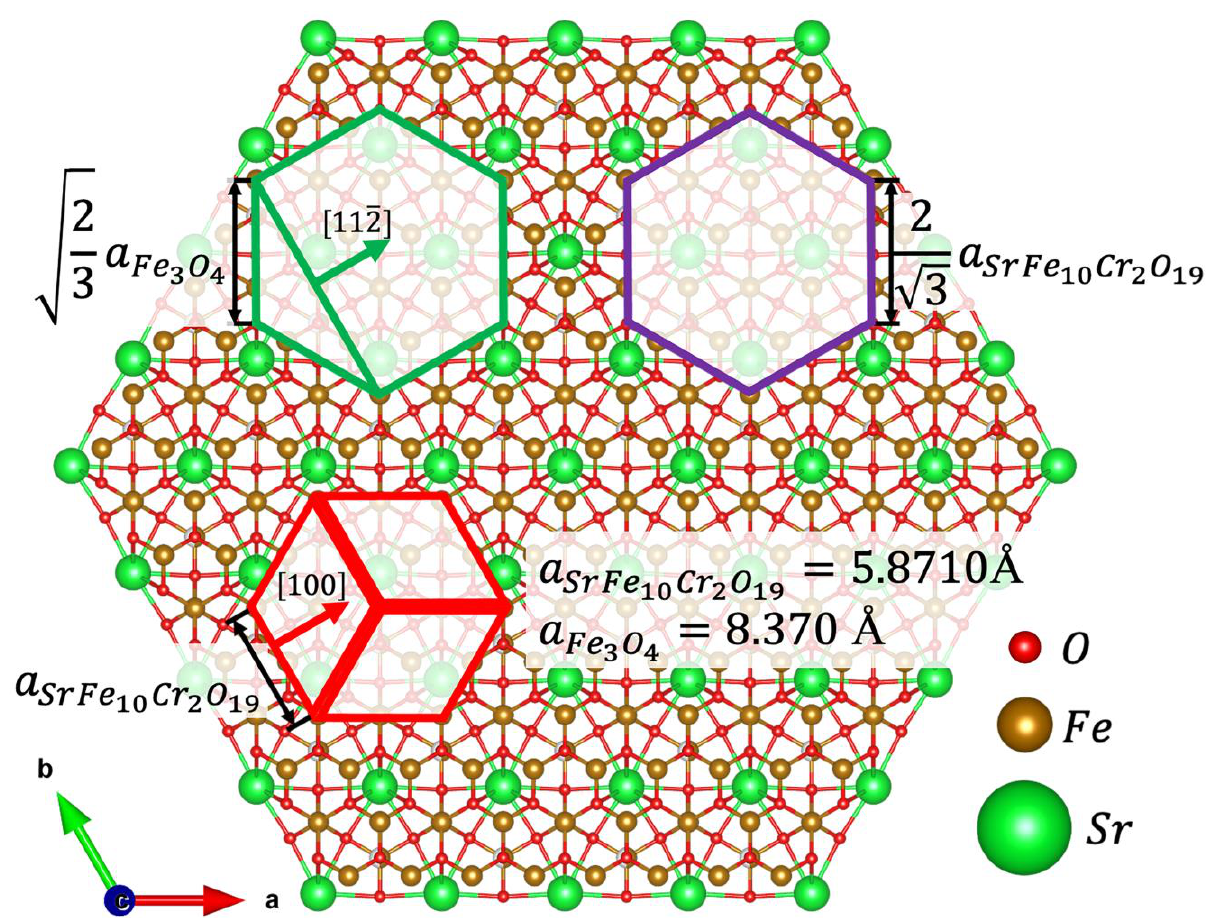
Figure 4. The atomic structure of the terminal SrFe 10 Cr 2 O 19 layer which participates in the formation of the interface with Fe 3 O 4 . The most favorable position of Fe 3 O 4 unit cell, SrFe 10 Cr 2 O 19 unit cell and a coincide cite lattice cell are marked as green, red, and purple hexagons respectively. Lengths of hexagon sides are presented in the lattice parameter units [34].